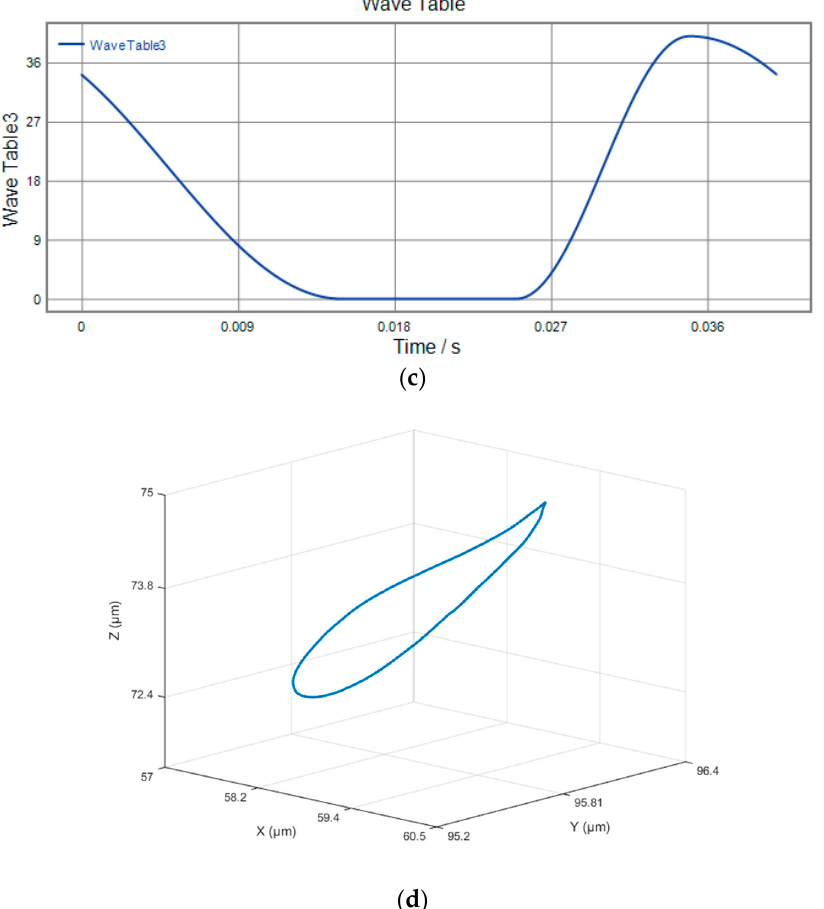
Figure 36. Experimental scenario 3. ( a ) x -direction input signal; ( b ) y -direction input signal; ( c ) z -direction input signal; ( d ) output trajectory.